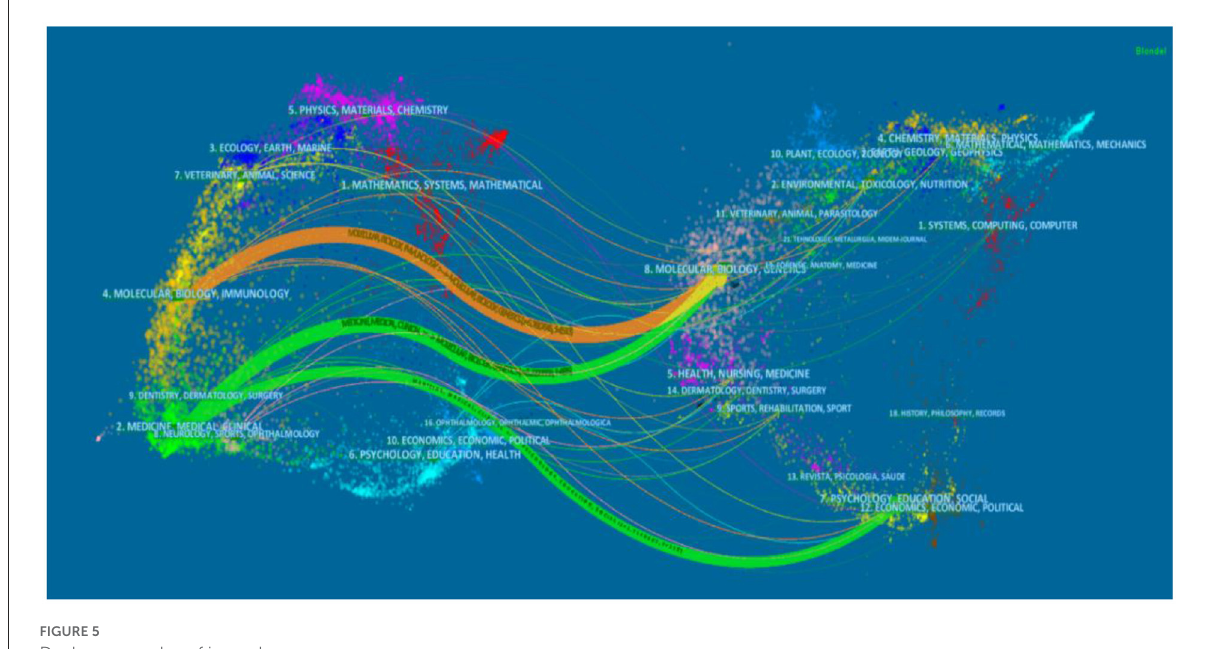
FIGURE5 Dual-map overlay of journals.